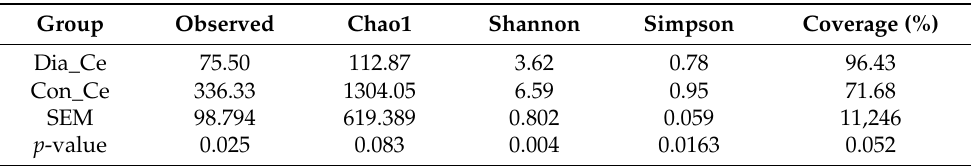
Figure 2. Comparison of fecal flora in cecum between Dia_Ce and Con_Ce. ( A ) ANOSIM analysis: R > 0, significant difference in two groups. ( B ) The number of unique and common OTUs between the two groups shown in the Venn diagram. ( C ) Relative abundance histogram of species at phylum level. ( D ) Relative abundance histogram of species at genus level. ( E ) LDA score of LEfSe – PICRUSt. Table 1. Alpha diversity of intestinal microbial of